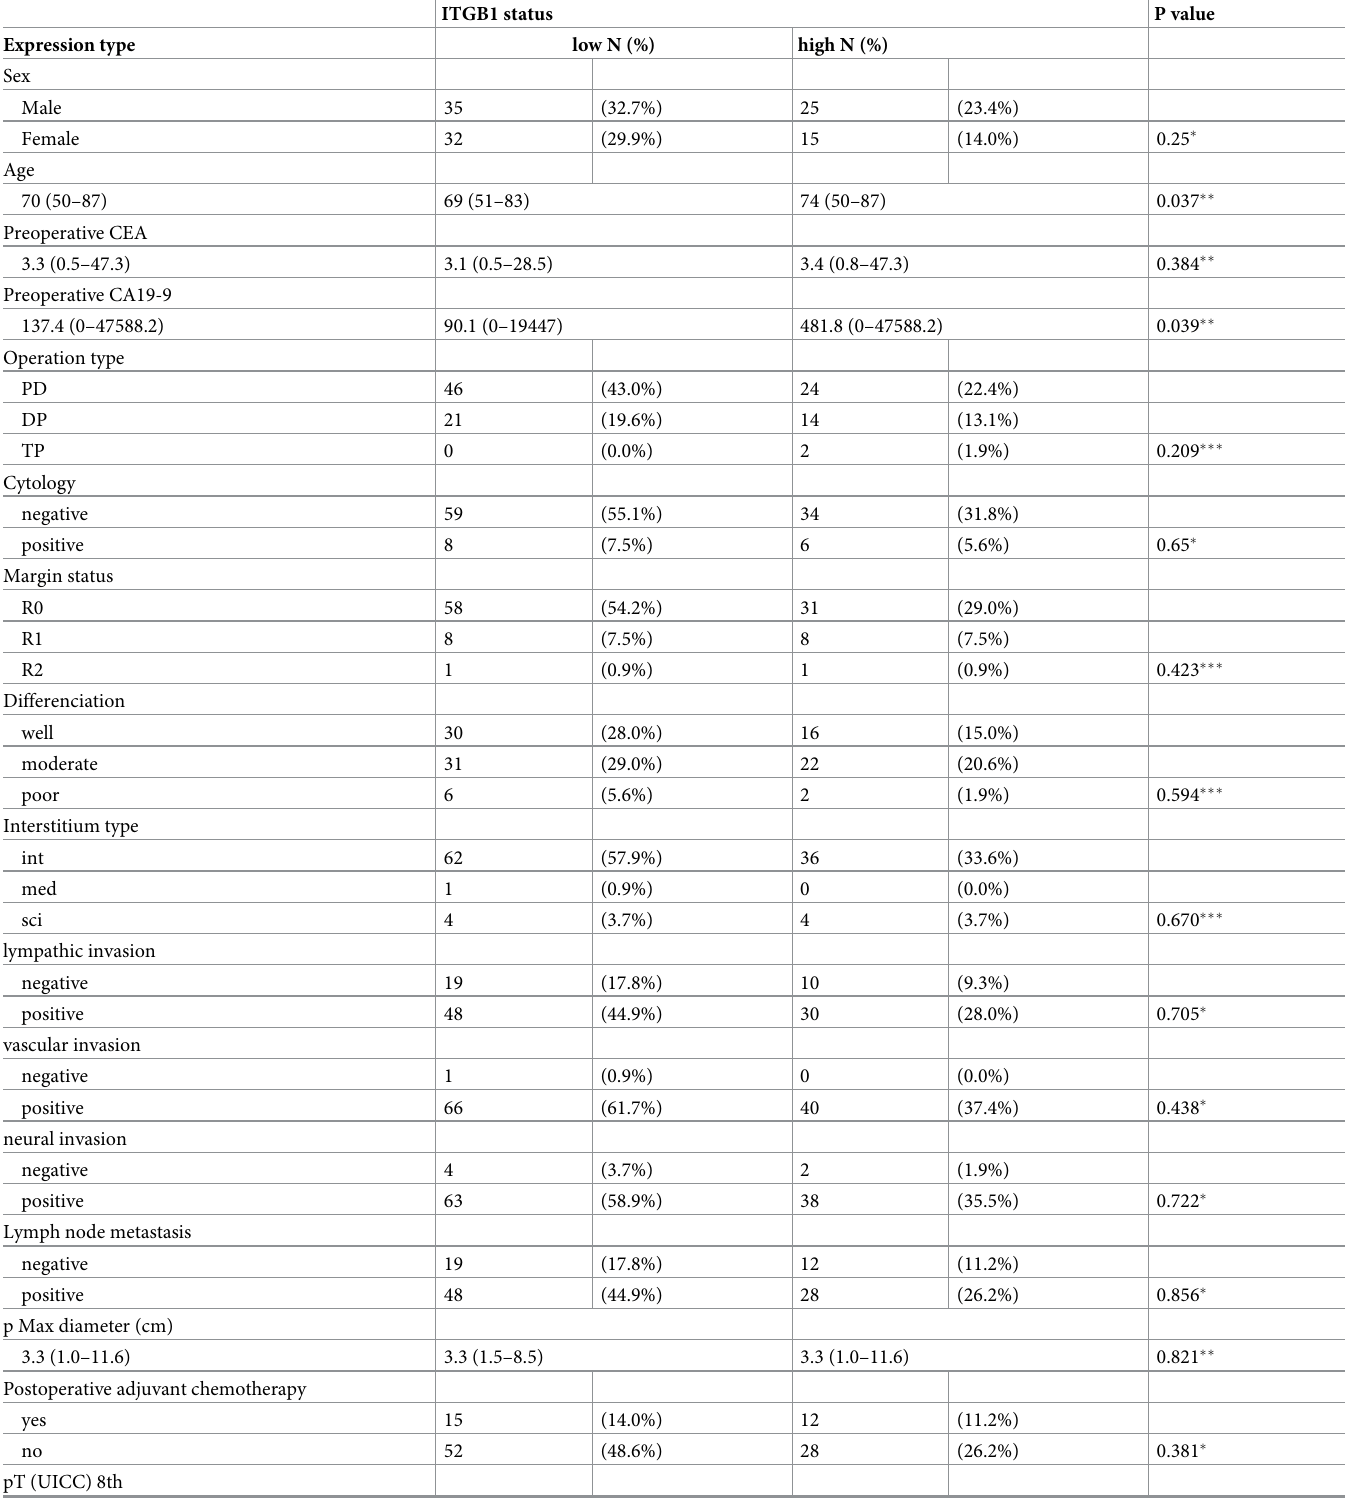
Table 1. Relationship between clinocopathological parameters and ITGB1